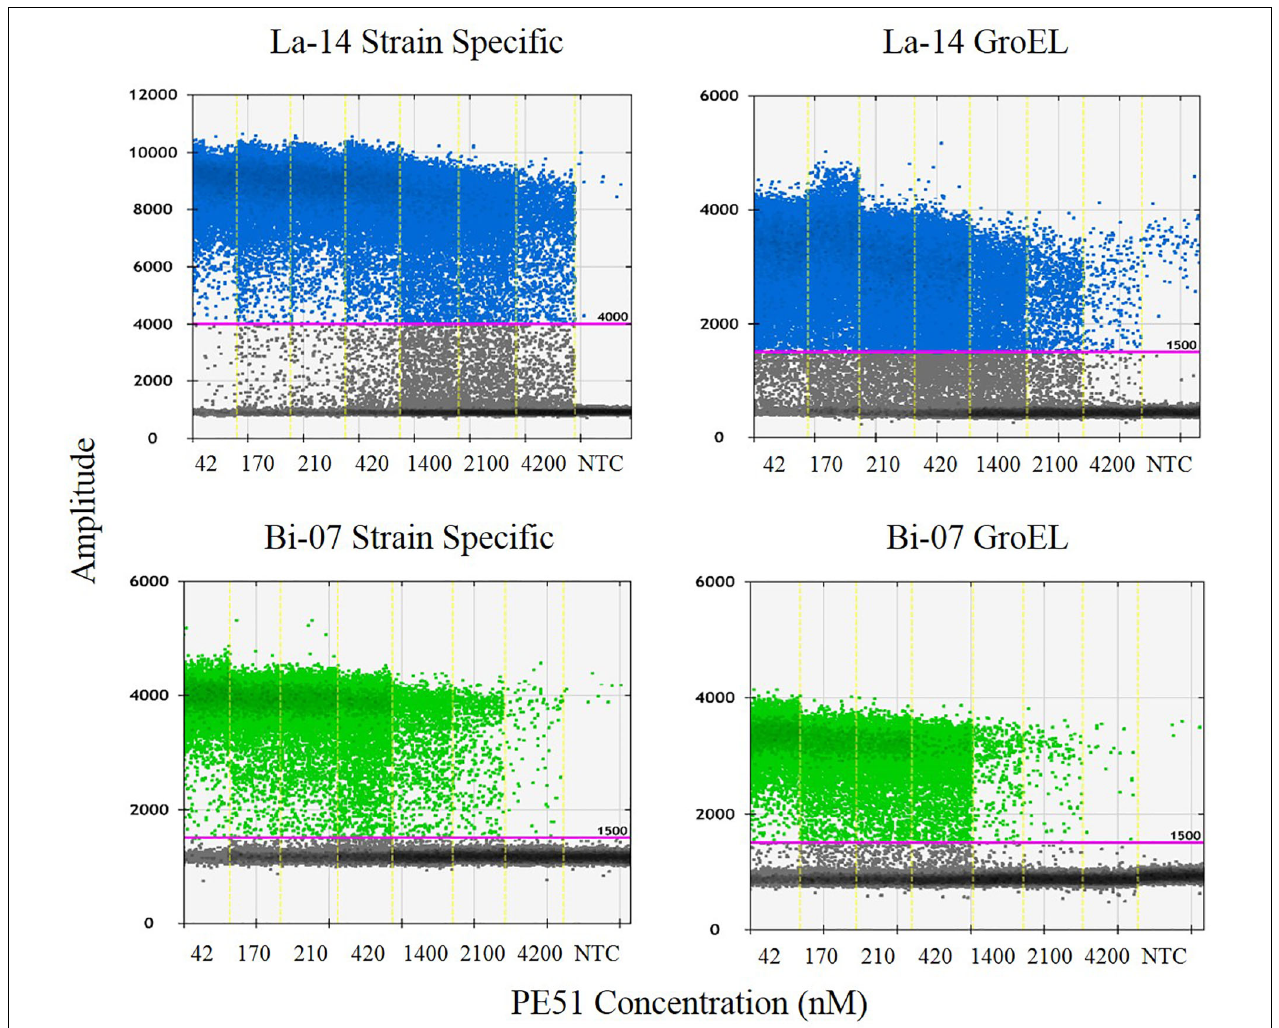
FIGURE 2 | QuantaSoft output demonstrating specified thresholds and summarizing the results from each assay and concentration tested. Also included is a no template control (NTC) result for each